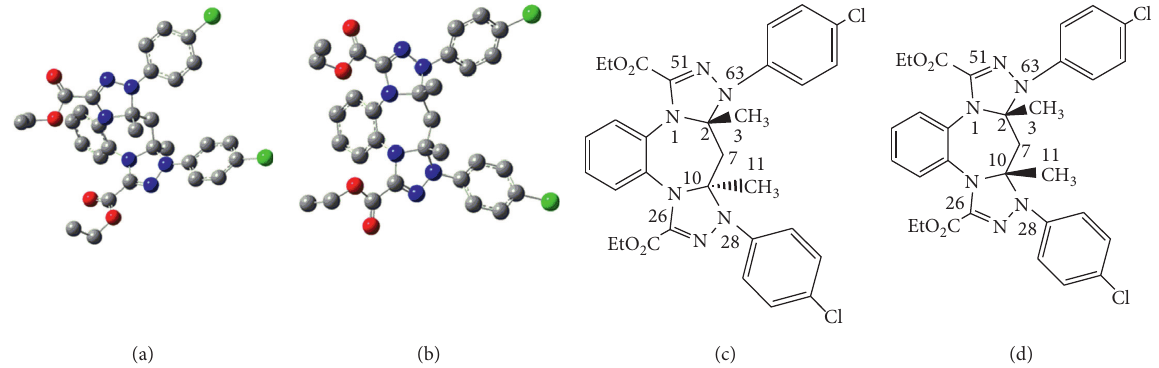
Figure 1: The lowest lying isomers ( 4-trans and 4 - cis ) on the total PES of the bis-cycloaddition. (a) 4-Trans (0.00 kcal/mol), (b) 4-cis (12.00kcal/mol), (c) 4-Trans , and (d) 4-cis . Table 1: Relative energies a (kcal/mol), binding lengths (˚A), and dihedral angle ( ° ) of the low-lying isomers of the bis-cycloaddition. 4-Trans 4-Cis Δ E (kcal/mol)